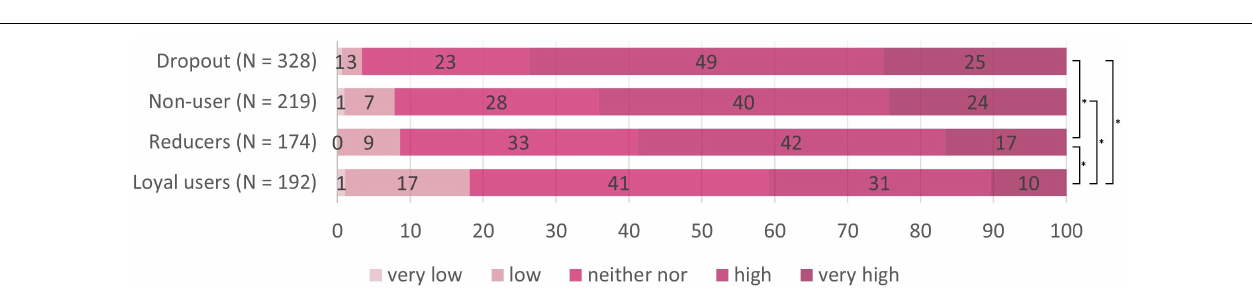
FIGURE 5 | Subjective risk perception for using the tram in the different target groups. N = 918; numbers on the bars represent percentages. * p < 0.008 in the pairwise comparisons.